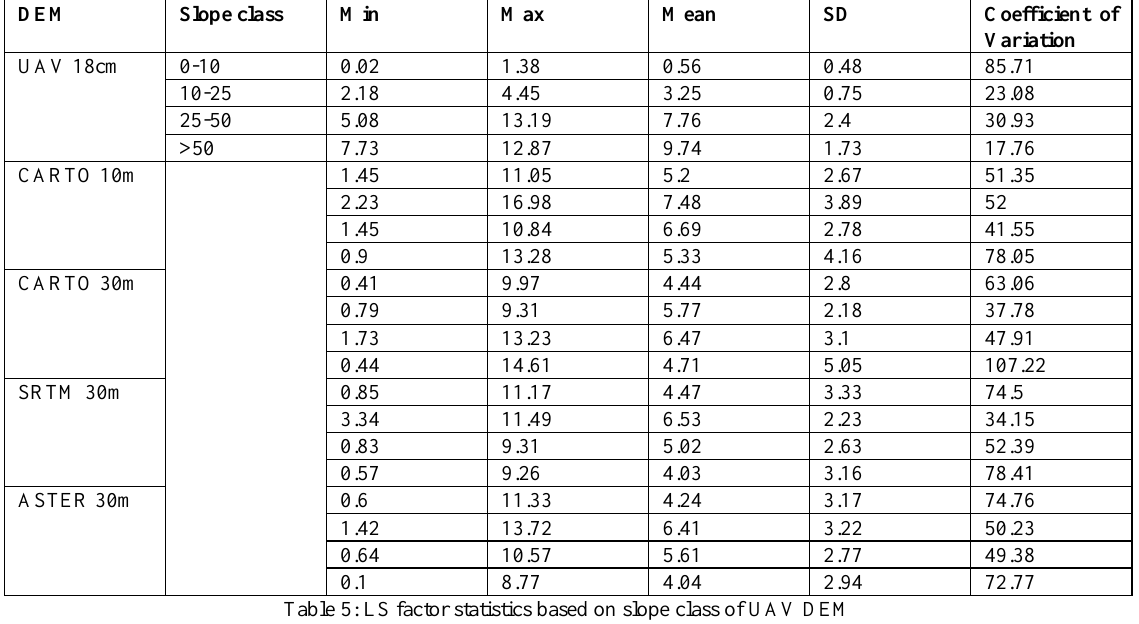
Table 5: LS factor statistics based on slope class of UAV DEM